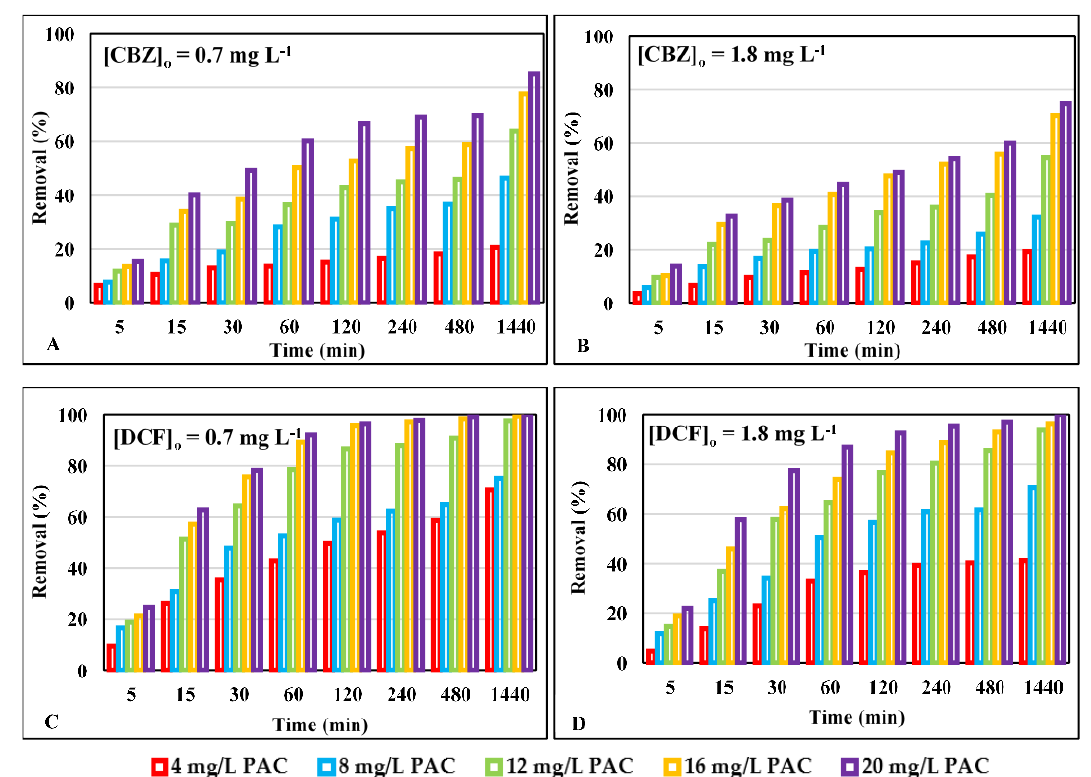
Figure 2. Removal percentages of CBZ and DCF over time at different PAC doses (4–20 mg L − 1 ): ( A ) [CBZ] 0 = 0.7 mg L − 1 ; ( B ) [CBZ] 0 = 1.8 mg L − 1 ; ( C ) [DCF] 0 = 0.7 mg L − 1 ; ( D ) [DCF] 0 = 1.8 mg L − 1 .